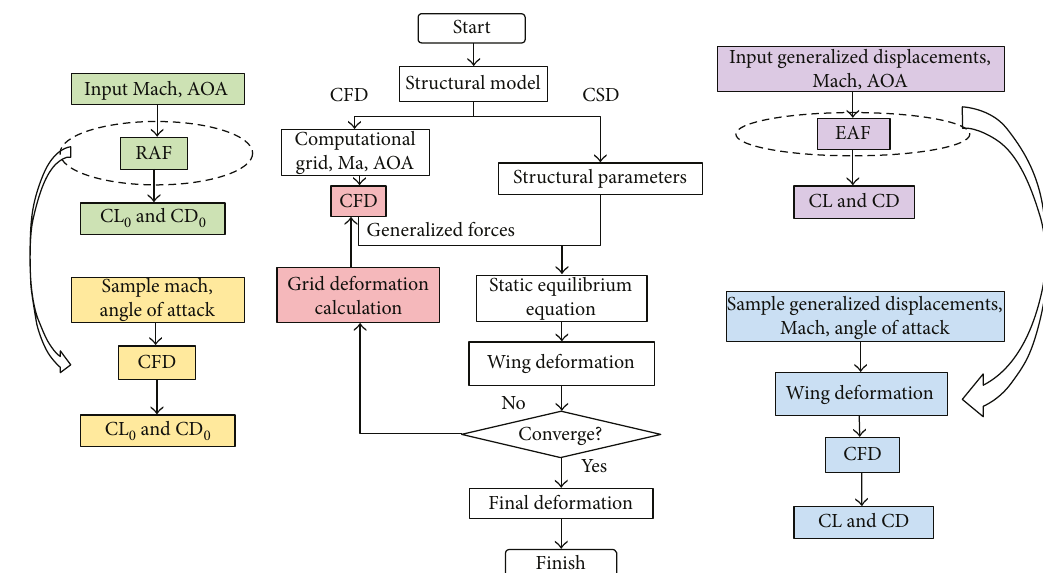
Figure 1: The fl ow chart of analysis.